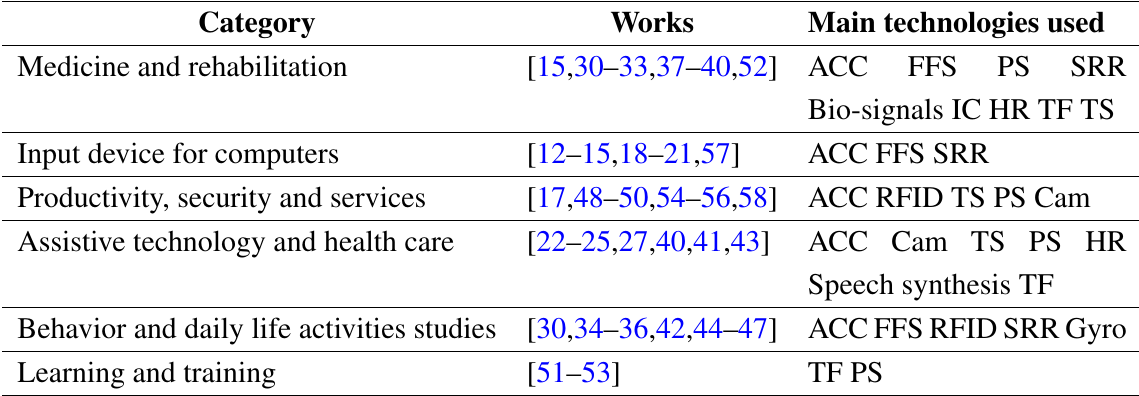
Table 1. Summary table of glove-based systems. Abbreviations: ACC = Accelerometers, FFS = Finger Flexion Sensors, Cam = Camera, IC = Internet Connectivity, HR = Heart rate sensor, TF = Tactile Feedback with vibration motor, PS = Pressure Sensor, SRR = Short Range Radio (Bluetooth, ZigBee, etc .), TS = Temperature